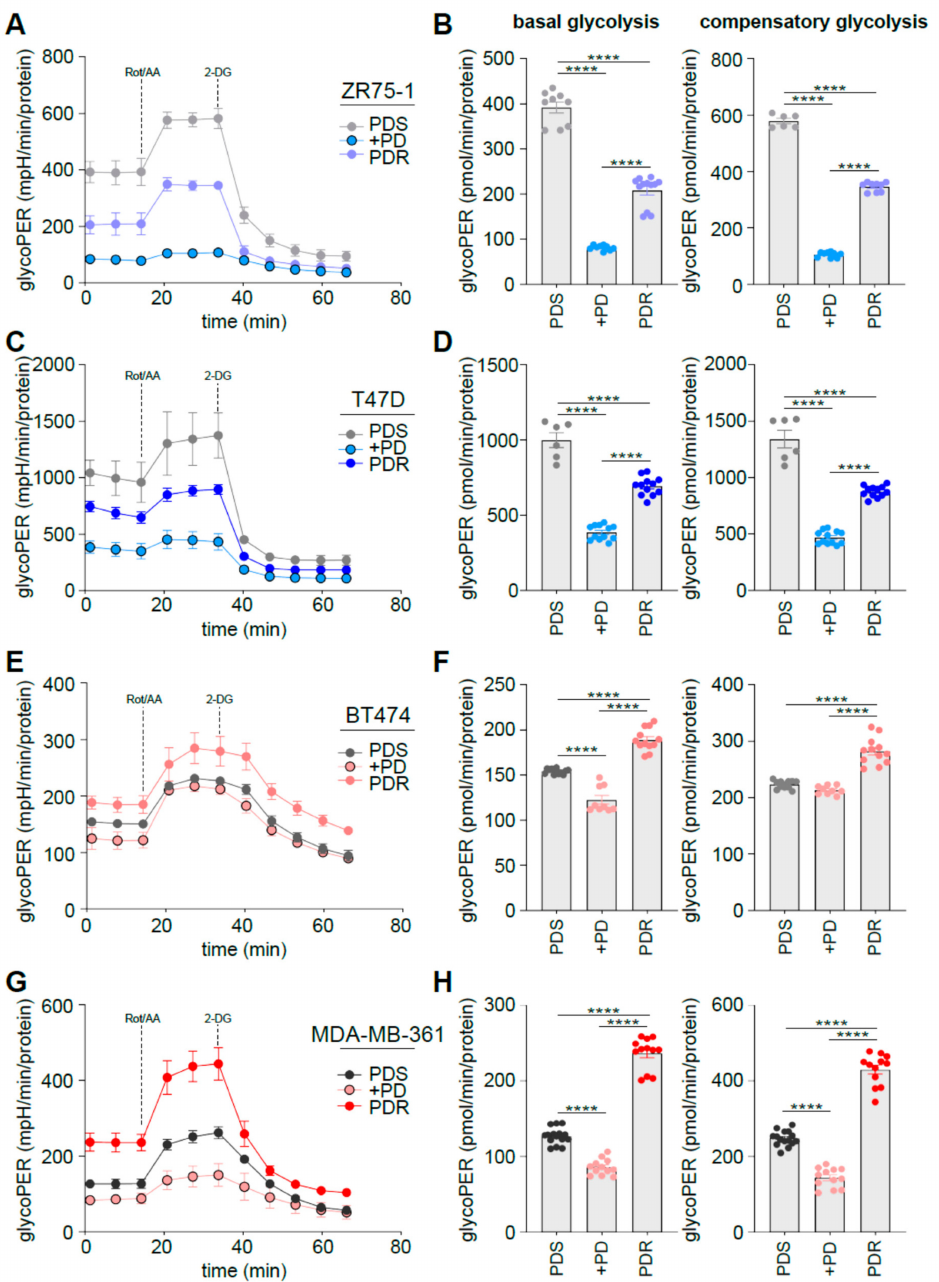
Figure 3. HER2 status impacts on glucose catabolism and reveals di ff erent glucose dependency during acute and chronic palbociclib administration. ( A , C , E , G ) PDS (either in presence or absence of 1 µ M palbociclib, PD) and PDR cells were subjected to seahorse XFe96 glycolytic rate analysis and glycolytic proton e ffl ux rate (glycoPER)) was measured in real time and normalized on protein levels. ( B , D , F , H ) Basal and compensatory (i.e., when electron transport chain is impaired) glycolytic capacity was calculated as described in Method Details, based on the extracellular acidification rate (ECAR) and oxygen consumption rate (OCR) after the administration of the respiratory complex I inhibitor rotenone, together with the respiratory complex III inhibitor antimycin A following by the glycolysis inhibitor 2-deoxy-glucose (2-DG). Data represent means ± SEMs. Each dot represents at least three technical replicates from three biological replicates. Blue dots are from HER2 − cells, red from HER2 + . One-way ANOVA; Dunnett’s corrected; **** p <